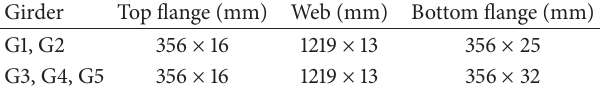
Table 1: Steel plate girder element dimensions (width × thickness).